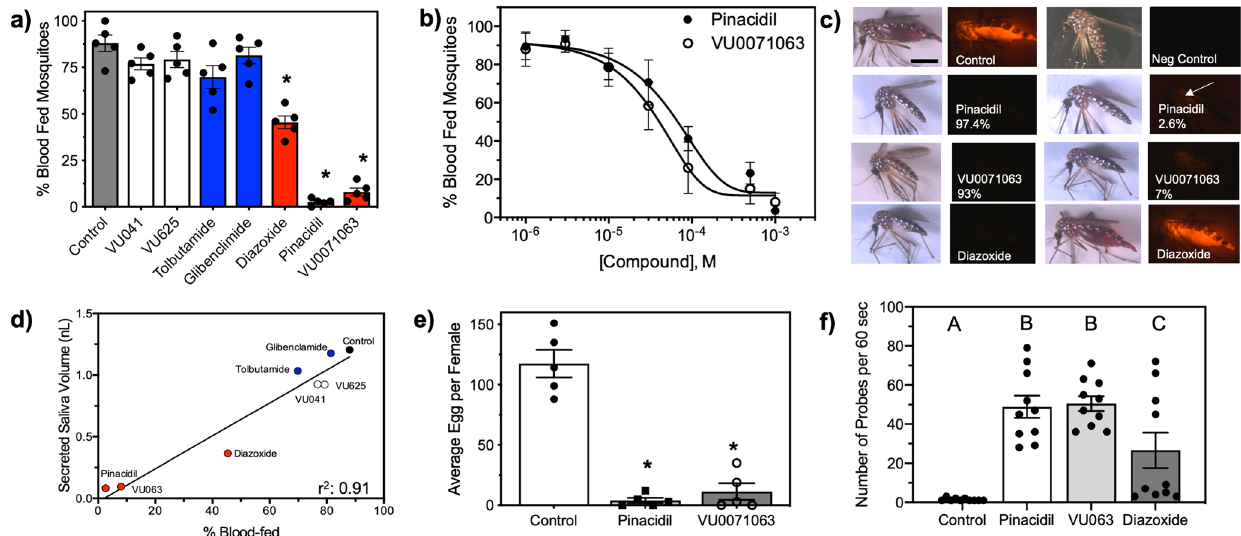
Fig. 3 In fl uence of Kir/K ATP channel modulators to blood-feeding biology of A. aegypti . a Percentage of mosquitoes that imbibed blood from a membrane feeding system when Kir modulators were dissolved into the blood meal at a concentration of 300 – 700 µ M. Feeding was assessed based on fl uorescence resulting from the inclusion of 100 ppm rhodamine B into the blood meal and any fl uorescence was considered a fed mosquito. Bars represent mean ( n = 5) percent feeding with each replicate consisting of 100 mosquitoes and error bars denote SEM. Statistical signi fi cance is denoted by the presence of an asterisk with * representing P < 0.001. b Concentration-response curve for the percentage of blood-fed mosquitoes after exposure to pinacidil (closed circle) or VU0071063 (open circle). Each data point represents mean ( n = 5) percent fed mosquitoes where each replicate consisted of 30 – 50 mosquitoes and error bars represent SEM. c Representative images of mosquitoes that were provided access to a blood meal treated with RhoB and K ATP activators. Percentages embedded into the image denote the percent mosquitoes that are represented by that image. Scale bar equals 1 mm. d linear regression analysis of salivary gland function to blood-feeding ef fi cacy. Goodness-of- fi t for the regression is indicated by the r 2 value. e Eggs laid per female after feeding on control, pinacidil, or VU0071063 treated blood meals. Bars represent the mean ( n = 5, 50 individuals per replicate) the number of eggs and error bars represent SEM. Asterisks represent statistical signi fi cance at P < 0.01 as determined by a one-way ANOVA. f Analysis of the number of probes per individual mosquito over a 180 s period. Bars represent mean ( n = 10) and error bars represent SEM. Bars not labeled by the same letter represent statistical signi fi cance at P < 0.05. See Supplemental Data 3 for underlying